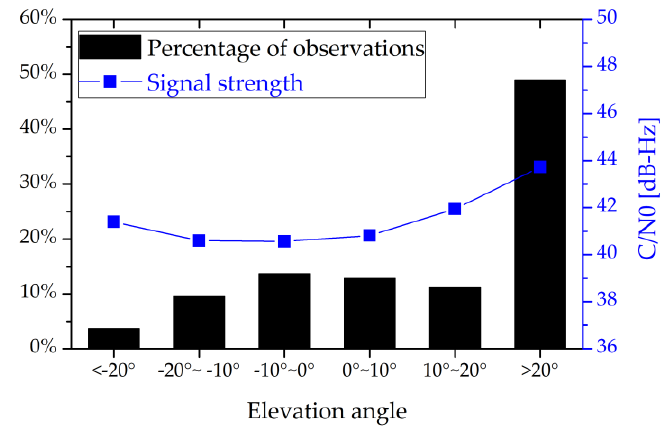
Figure 7. Percentage and signal strength of observations. The histogram is the percentage of obser- vations and the blue line denotes the signal strength.